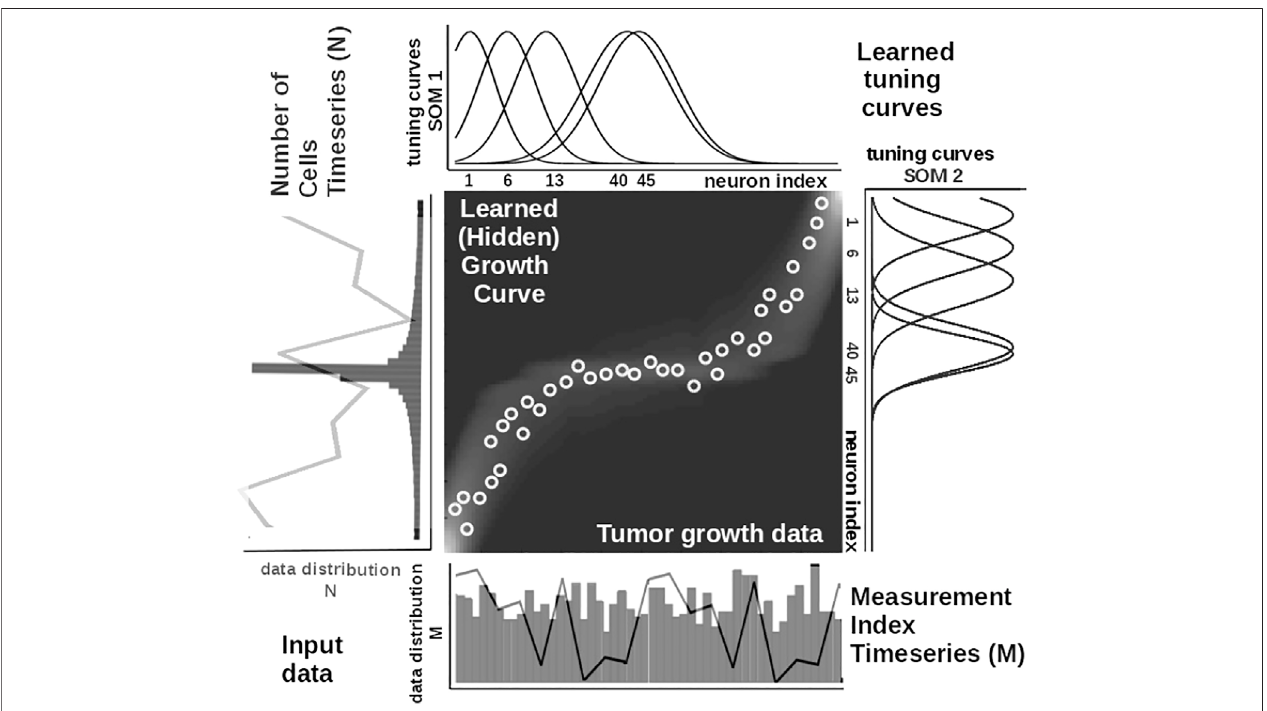
FIGURE 4 | Extracted mathematical relation describing the growth law and data statistics for the experimental observations in Figure 2A depicting a cubic breast cancer tumor growth law among number of cells and irregular measurement over 150 weeks from Comen et al. (2016). Raw data time series is overlaid on the data distribution and corresponding model encoding tuning curves